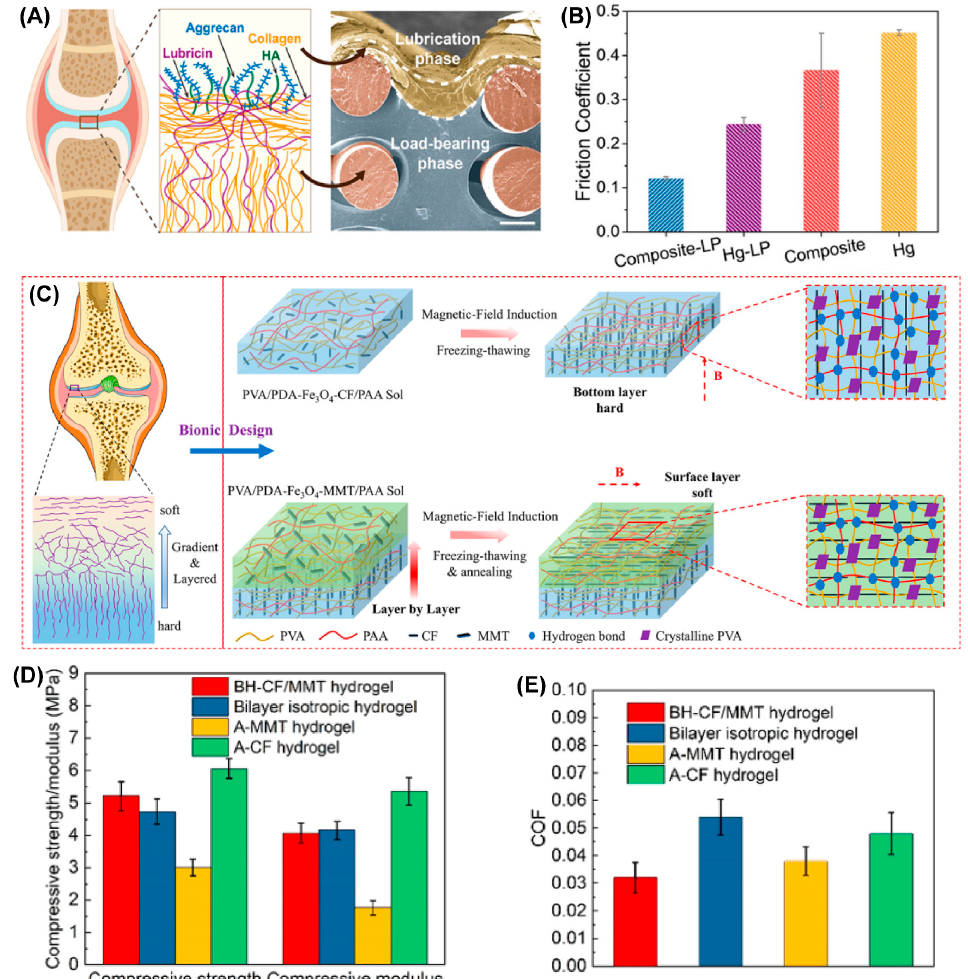
Figure 5. Typical cartilage structure-inspired hydrogels. ( A ) The main components consisted of an AC lubrication system within the AC superficial layer (left). The SEM cross-sectional morphology of Composite-LP, which clearly shows the load-bearing phase and lubrication phase (right). ( B ) The friction coefficients of the Composite-LP, Hg-LP, Composite, and Hg samples (load, 1 N; frequency, 1 Hz). Panels ( A ) and ( B ) are reprinted with permission from Ref [25]. Copyright 2022, American Chemical Society. ( C ) Schematic illustration of the bilayer-oriented heterogeneous hydrogel (BH-CF/MMT hydrogel). ( D ) The compressive strength and compressive modulus ( D ) and the average friction coefficient ( E ) of the bilayer-oriented heterogeneous hydrogel compared with control groups (bilayer unoriented hydrogel, A-MMT hydrogel, and A-MMT hydrogel). Reprinted with permission from Ref [70]. Copyright 2022, American Chemical Society.